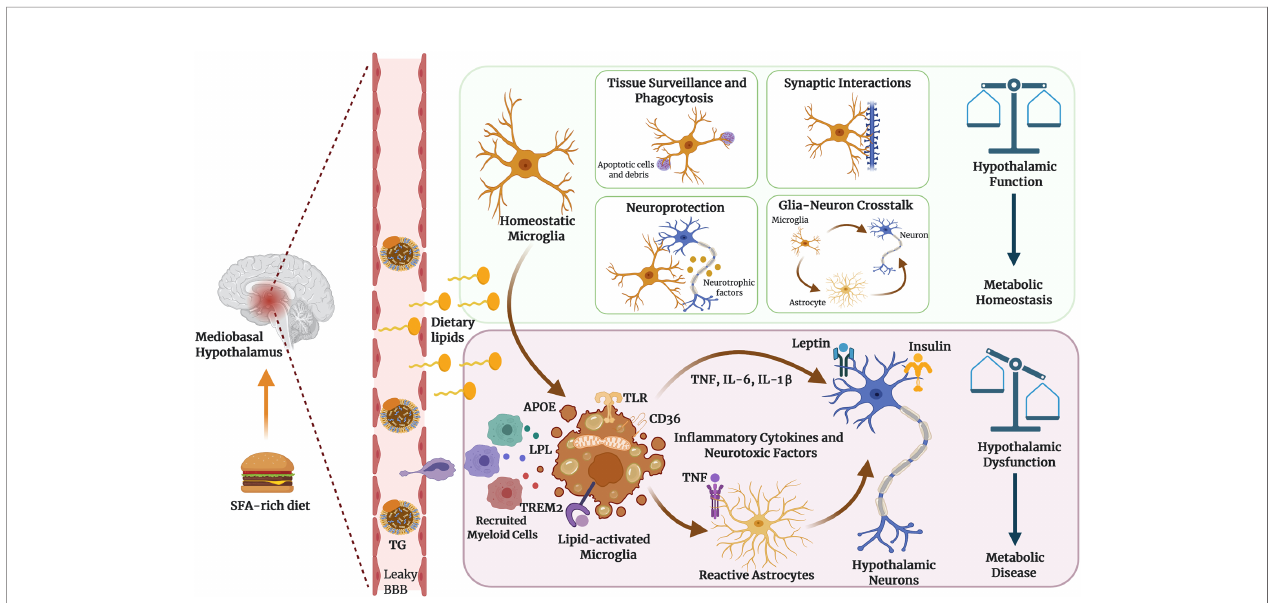
FIGURE 1 | Microglia as dynamic cellular mediators of hypothalamic function. Microglia can perform diverse functions to maintain brain homeostasis, actively screening the surroundings, intercellular communication and remodeling the brain circuits through synaptic pruning and neuronal plasticity. Hypothalamic microglia integrate systemic metabolic signals such as dietary lipids to establish functional states that in fl uence neuronal control of energy homeostasis. TG: refers to triglyceride-rich lipoproteins, including chylomicrons and VLDL particles. Figure created with